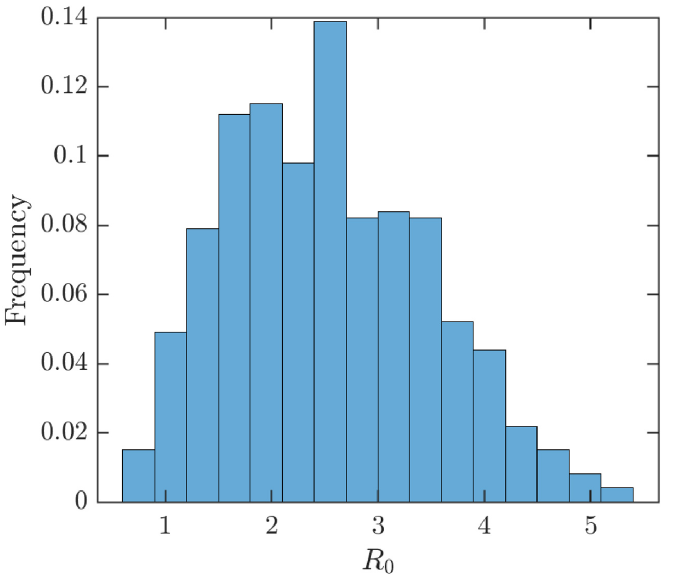
Fig 2. Uncertainty analysis of R 0 . Parameter values and ranges as specified in Table 1. The average value of R 0 is about 2.53.